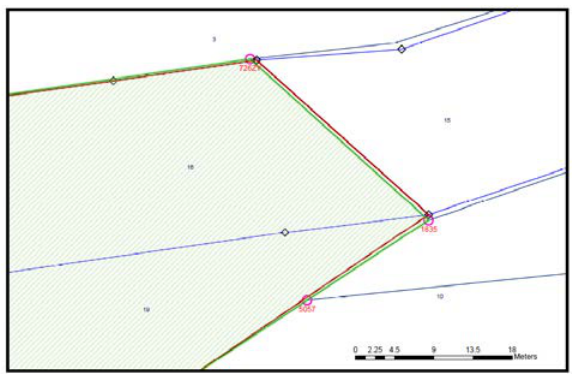
Figure 7: Conflating two parcel files using counterpart